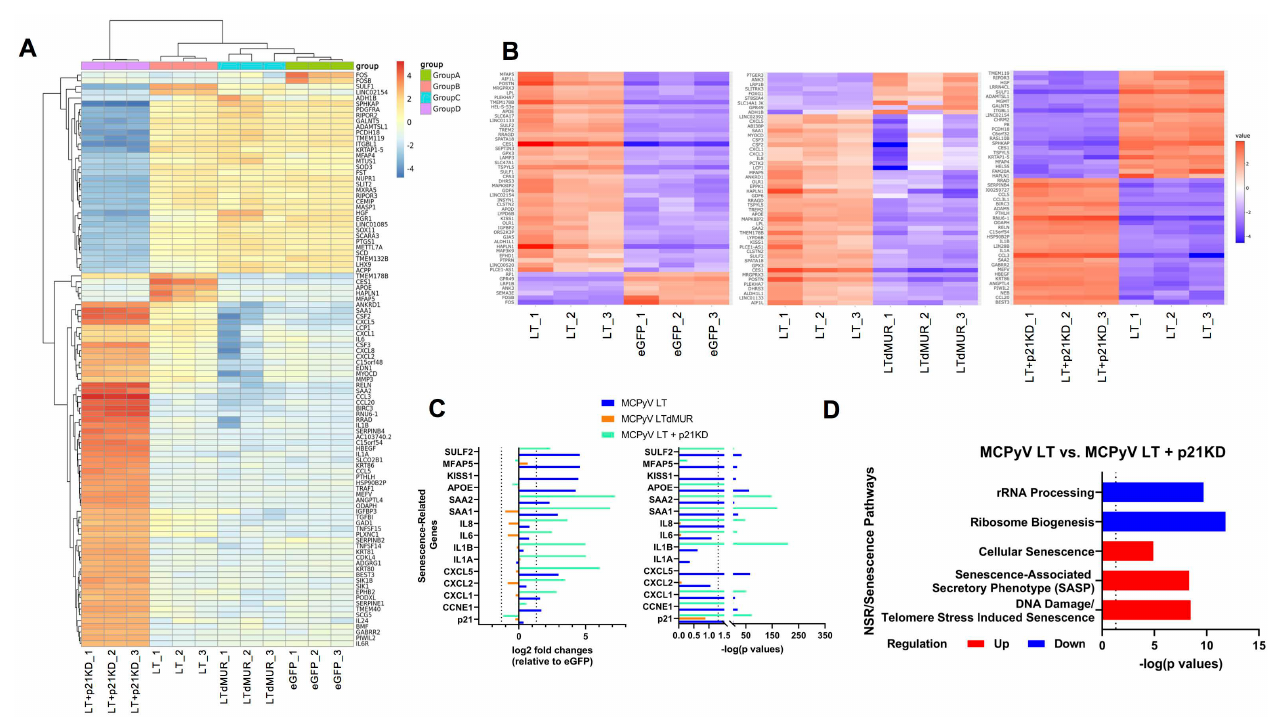
Figure 5. MCPyV LT − expressing cells are enriched in senescence − related genes. ( A ) Heatmap comparing top 100 differentially expressed genes, comparing eGFP, MCPyV LT, MCPyV LTdMUR, MCPyV LT+p21KD. ( B ) Heatmaps comparing the top 50 differentially expressed genes between MCPyV LT:eGFP (left), MCPyV LT:MCPyV LTdMUR (middle), MCPyV LT:MCPyV LT+p21KD (right). Heatmaps were generated using iDEP. ( C ) SASPs expression. Expression of senescence − related genes compared to eGFP empty vector cells. Log 2 fold changes (left): positive values represent upregulated genes compared to eGFP cells and negative values represent downregulated genes compared to eGFP cells. Vertical dashed lines represent +/ − 1.5 log 2 fold change with a false discovery rate (FDR) of 0.1. − log( p values) of senescence genes (right). Dotted line represents p value of